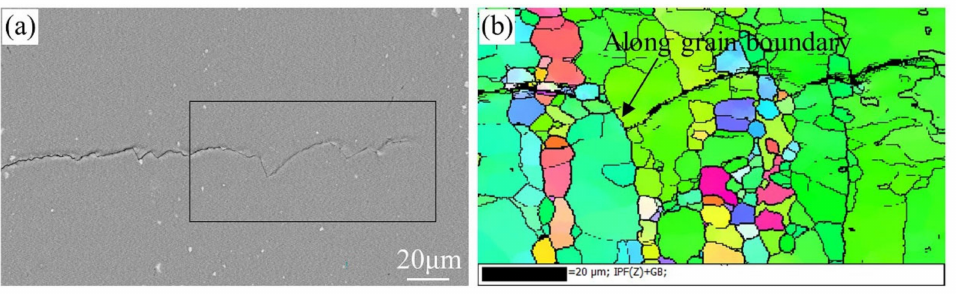
Figure 16. Fatigue crack propagation path at Paris regime of the T573 alloy ( a ) SEM and ( b )